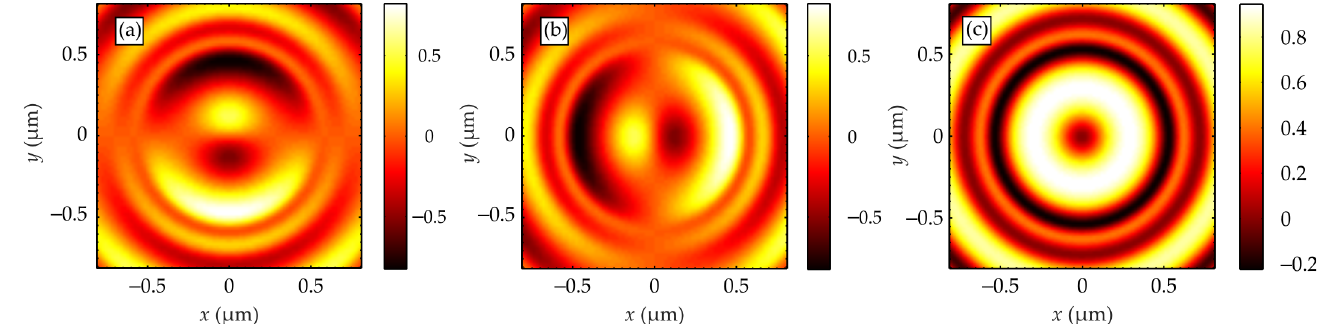
Figure 11. Distribution of the three components of the normalized Stokes vector S 1 ( a ), S 2 ( b ), S 3 ( c ) in the plane of focus when an optical vortex ( m = − 1) is focused by a flat diffractive lens with NA = 0.95.